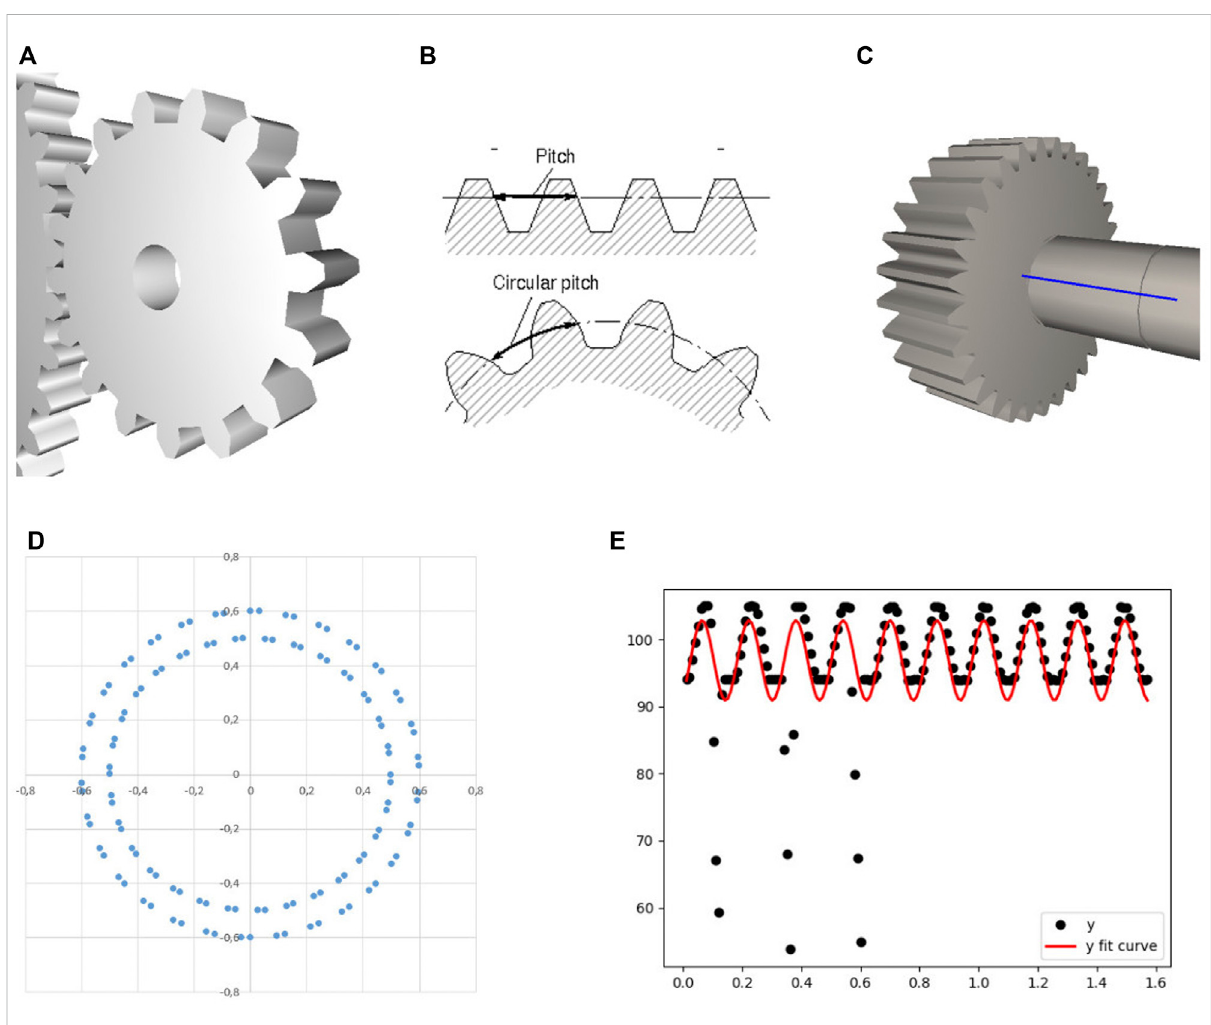
FIGURE 7 Process of geometry analysis to segment gear parameters like the pitch and teeth